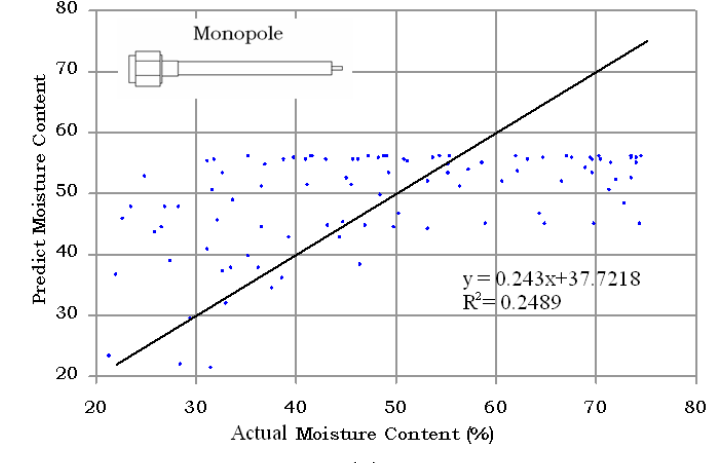
Figure 8. Comparison between predicted and actual moisture content. (a) Magnitude; (b) Phase methods using monopole